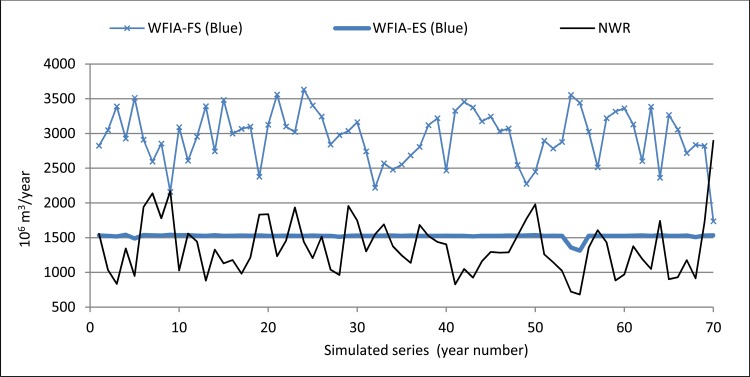
WFIABlue values with both methodologies and natural water resources (NWR).